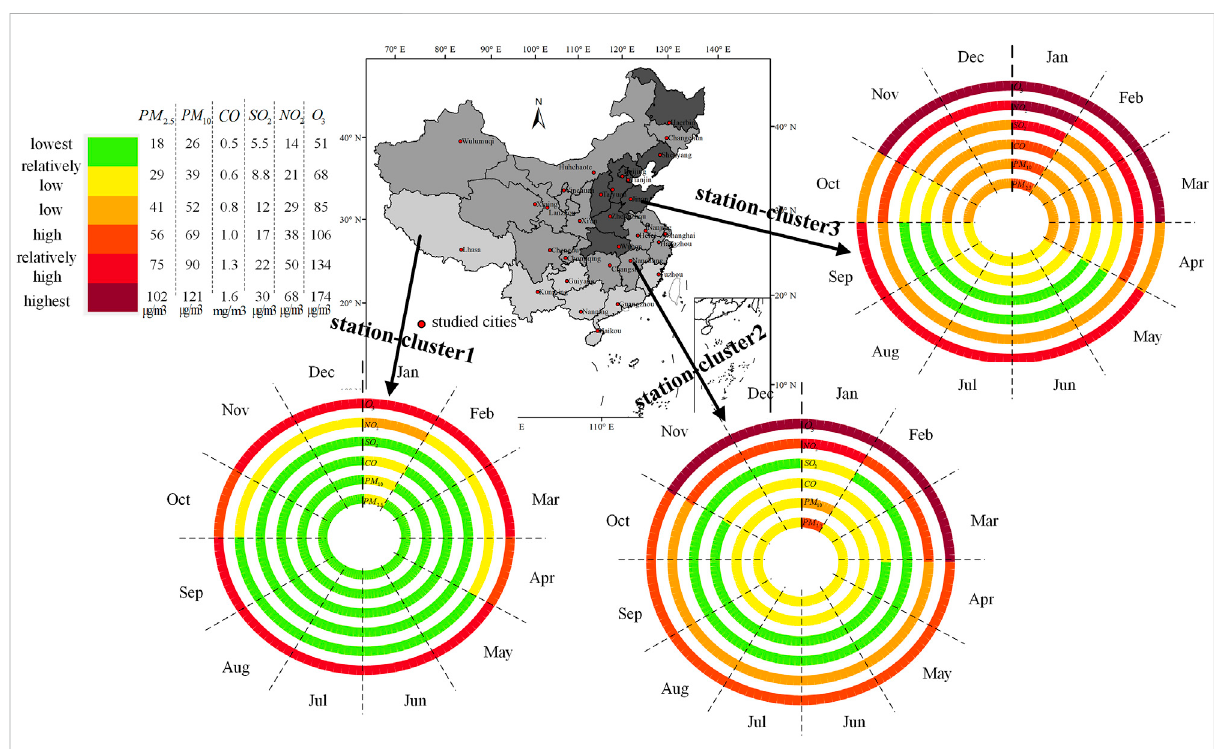
FIGURE 8 Spatial heterogeneity of relationships among six air pollutants from the perspective of station clusters; the map indicates spatial distribution of station clusters with coverage indicated by provinces of corresponding cities (stations) in that station